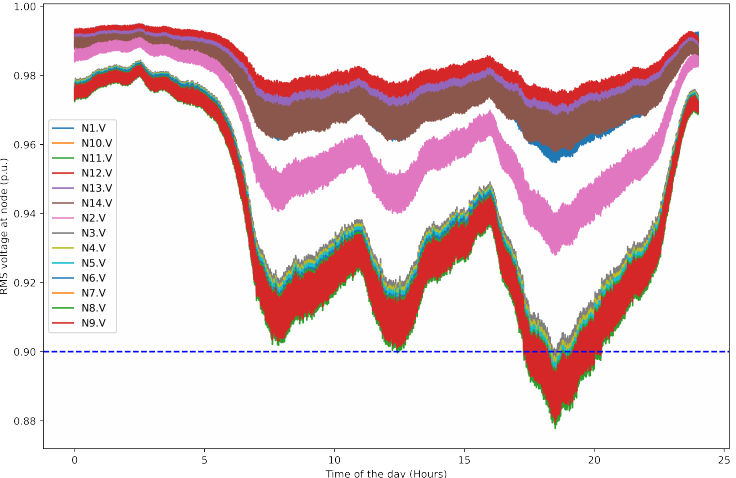
Figure 8. Node RMS voltage profile with 80% EV